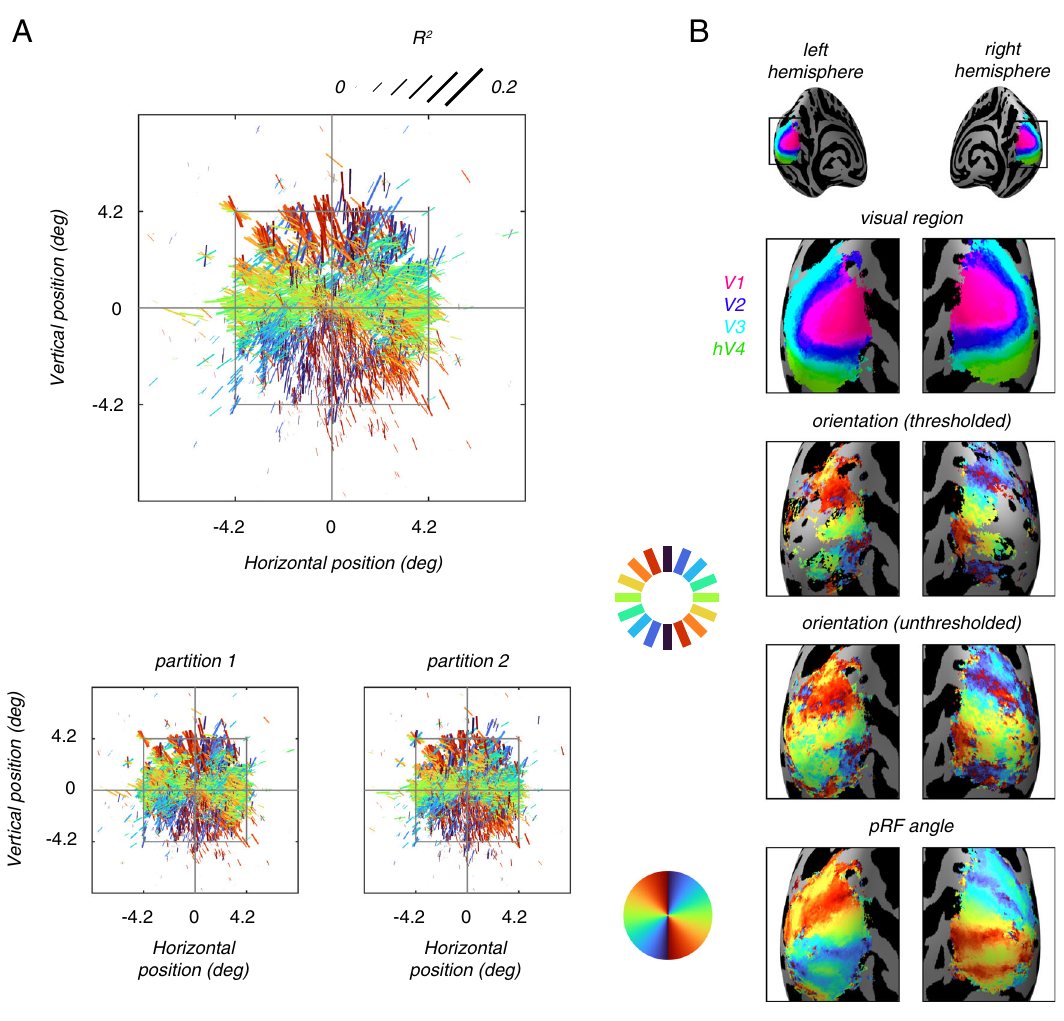
Fig. 3 | Orientation preference changes smoothly across visual space and V1. A Orientation preferences are plotted in visual space. Each line represents a single voxel and is positioned at the voxel ’ s pRF center. Hue and orientation of the line indicate the preferred orientation. Line length, width, and scale re fl ectthe amount of variance ( R 2 ) explained by the constrained model. A solid square at ±4.2deg indicates the size of the natural scene stimuli. See also individual subject plots in